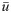
Frequency transitions in a random network of spiking neurons.A. Schematic illustration depicting some features of the network model, in which interconnected cells are driven by independent sources of noise. Individual cells are connected via excitatory (red) and inhibitory (blue) synaptic connections. B. Synaptic connectivity matrix. Weights are randomly distributed around a mean value g (See Eq 2). C. Sample network activity, in which neurons spike timing is modulated by global, slow-wave synchronous oscillations in both low (grey; D = 0.01) and high (blue; D = 0.50) input conditions. Faster and more irregular firing modulations characterize the high-input state. D. Power spectral density of the network mean activity u¯ in low (grey; D = 0.01) and high (blue; D = 0.50) input conditions. Other parameters are α = 100Hz, β = 300mV, g = −10mV/Hz, s = 20mV/Hz, τ = 25ms.